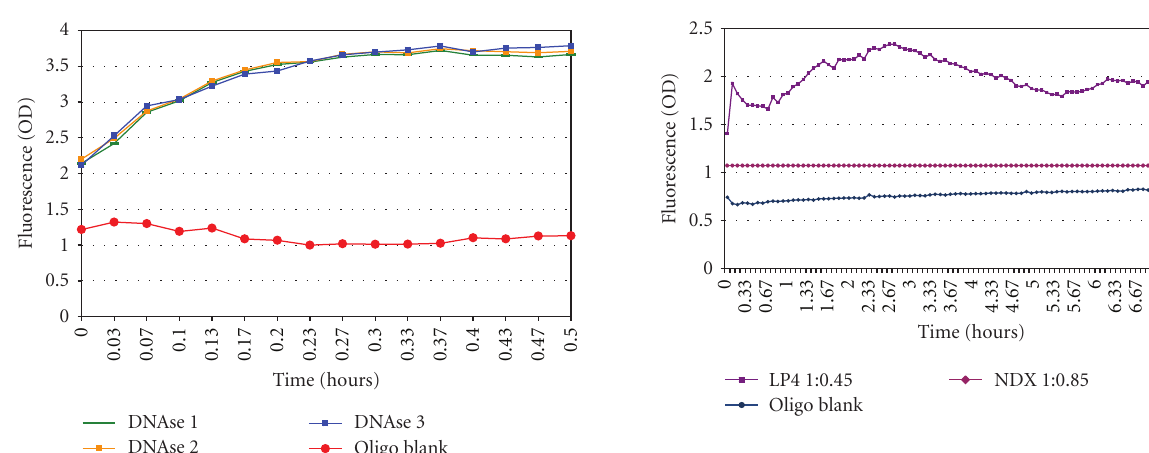
Figure 6: Continuous measurement of oligo 18-mer hydrolysis by lupus patient (LP) versus normal healthy donor (ND) by fluores- cence assay. ∗ Comparison of lupus patient-derived anti-poly-(dT) ssDNA antibody (LP4) and normal healthy donor-derived anti- poly-(dT) ssDNA antibody (NDX) via continuous fluorescence- based assay on Fluoroskan II (Finstruments) demonstrates that 5 (cid:3) -6-FAM-ATATAGCGC 5 T 5 -DQ1-3 (cid:3) 18-mer hydrolysis probe is cleaved by lupus patient-derived antibody but not by normal donor- derived antibody. Oligo blank contained all reaction components except for antibody (25mM Tris-HCl, 50 mM NaCl, 10 mM MgCl 2 , pH 7.5, and 1 μ g/mL 5 (cid:3) -6-FAM-ATATAGCGC 5 T 5 -DQ1-3 (cid:3) 18-mer hydrolysis probe). ANOVA indicates all three fluorescence patterns of LP4, NDX, and the oligo control are significantly di ff erent from each other at P < 0 .